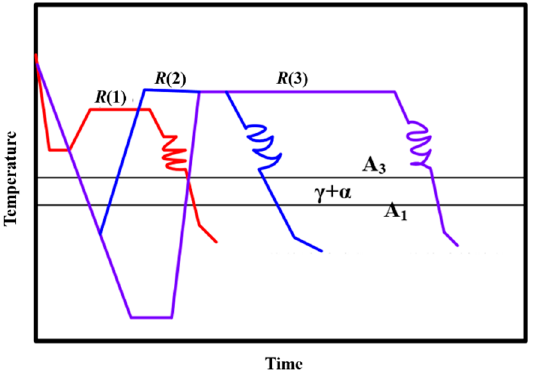
Figure 2. Comparison between conventional casting and compact strip processing.